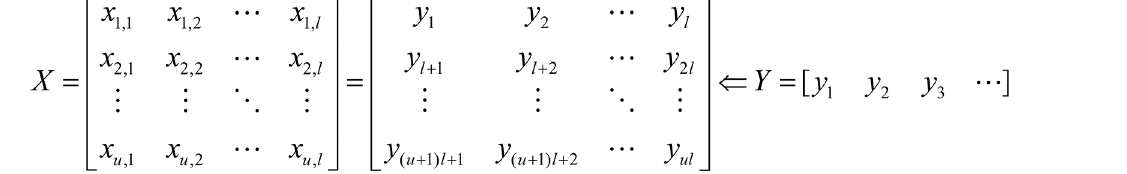
Fig 2. The mapping relation between matrix X and vector Y